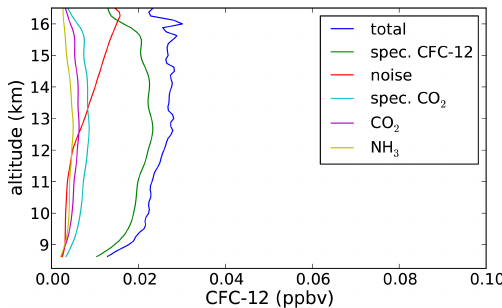
Figure 11. Error budget for CFC-12 for GLORIA Image 72.